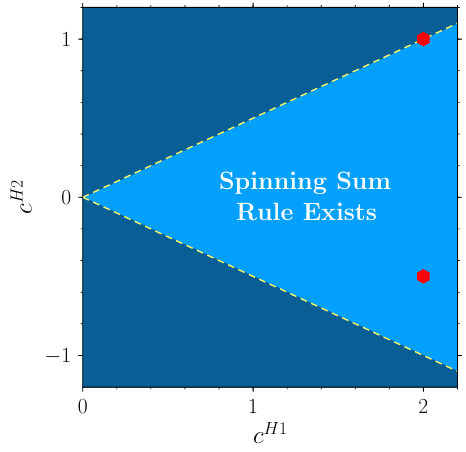
Figure 1 . The cone within which the coefficients of the two Higgs operators in table 1— O H 1 and O H 2 — can be chosen such that we can construct a spinning sum rule: a relationship between the sign of the IR coefficients and the dominant spin in the UV completion. The edges of the cone extend from the origin out through 2 c H 1 ± c H 2 , which are both constructed explicitly in the text. The hexagons show the specific sum rules considered in eq. (4.5), and the figure highlights that these are just two examples of a broad class of sum